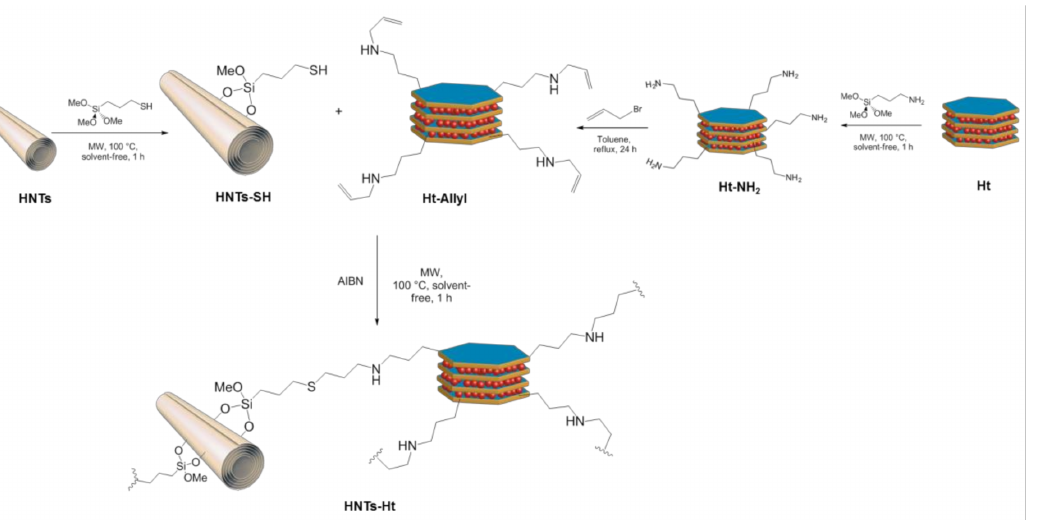
Scheme 1. Schematic representation of HNTs-Ht nanomaterial